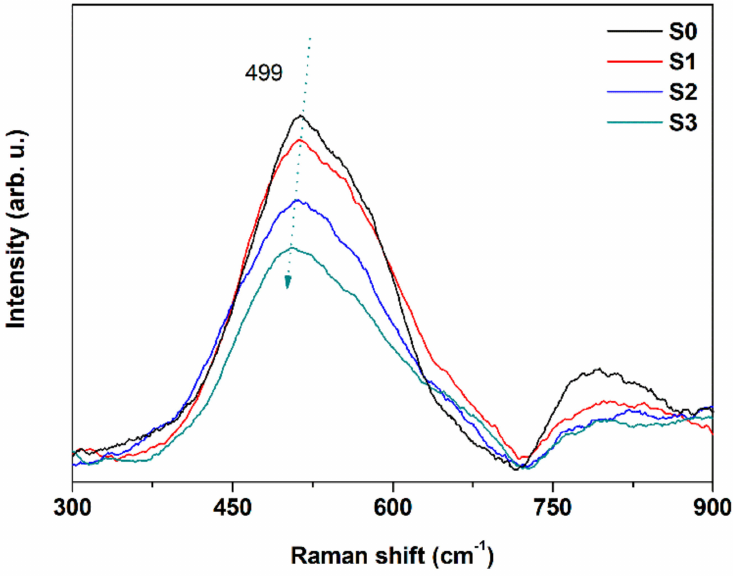
Figure 6. Raman spectra of the as-deposited and annealed ITO